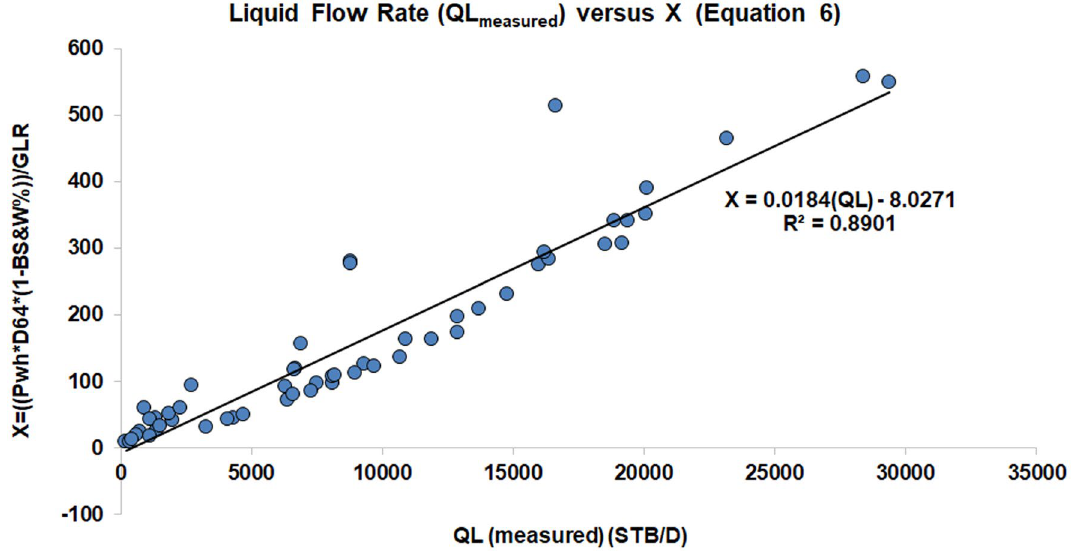
Fig. 3 Liquid production rate Q